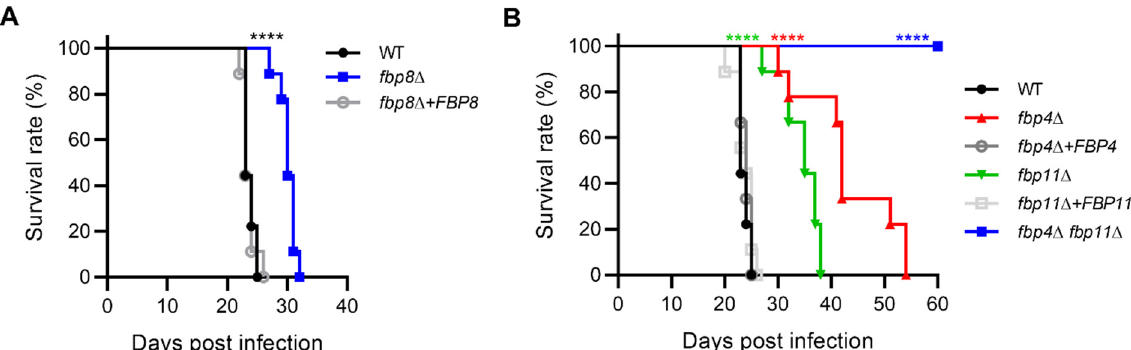
Figure 5. F-box proteins regulate virulence in a murine inhalation model. Survival curves for mice after intranasal infection with fbp8 ∆ ( A ), or fbp4 ∆ , fbp11 ∆ , or the fbp4 ∆ fbp11 ∆ double mutant ( B ). 6–8-week-old Female BALB/C mice ( n = 10/group) were inoculated intranasally with 10 5 cells of each strain and monitored for survival. Statistical analysis was performed based on Log-rank (Mantel–Cox) test. ****, p ≤ 0.0001.